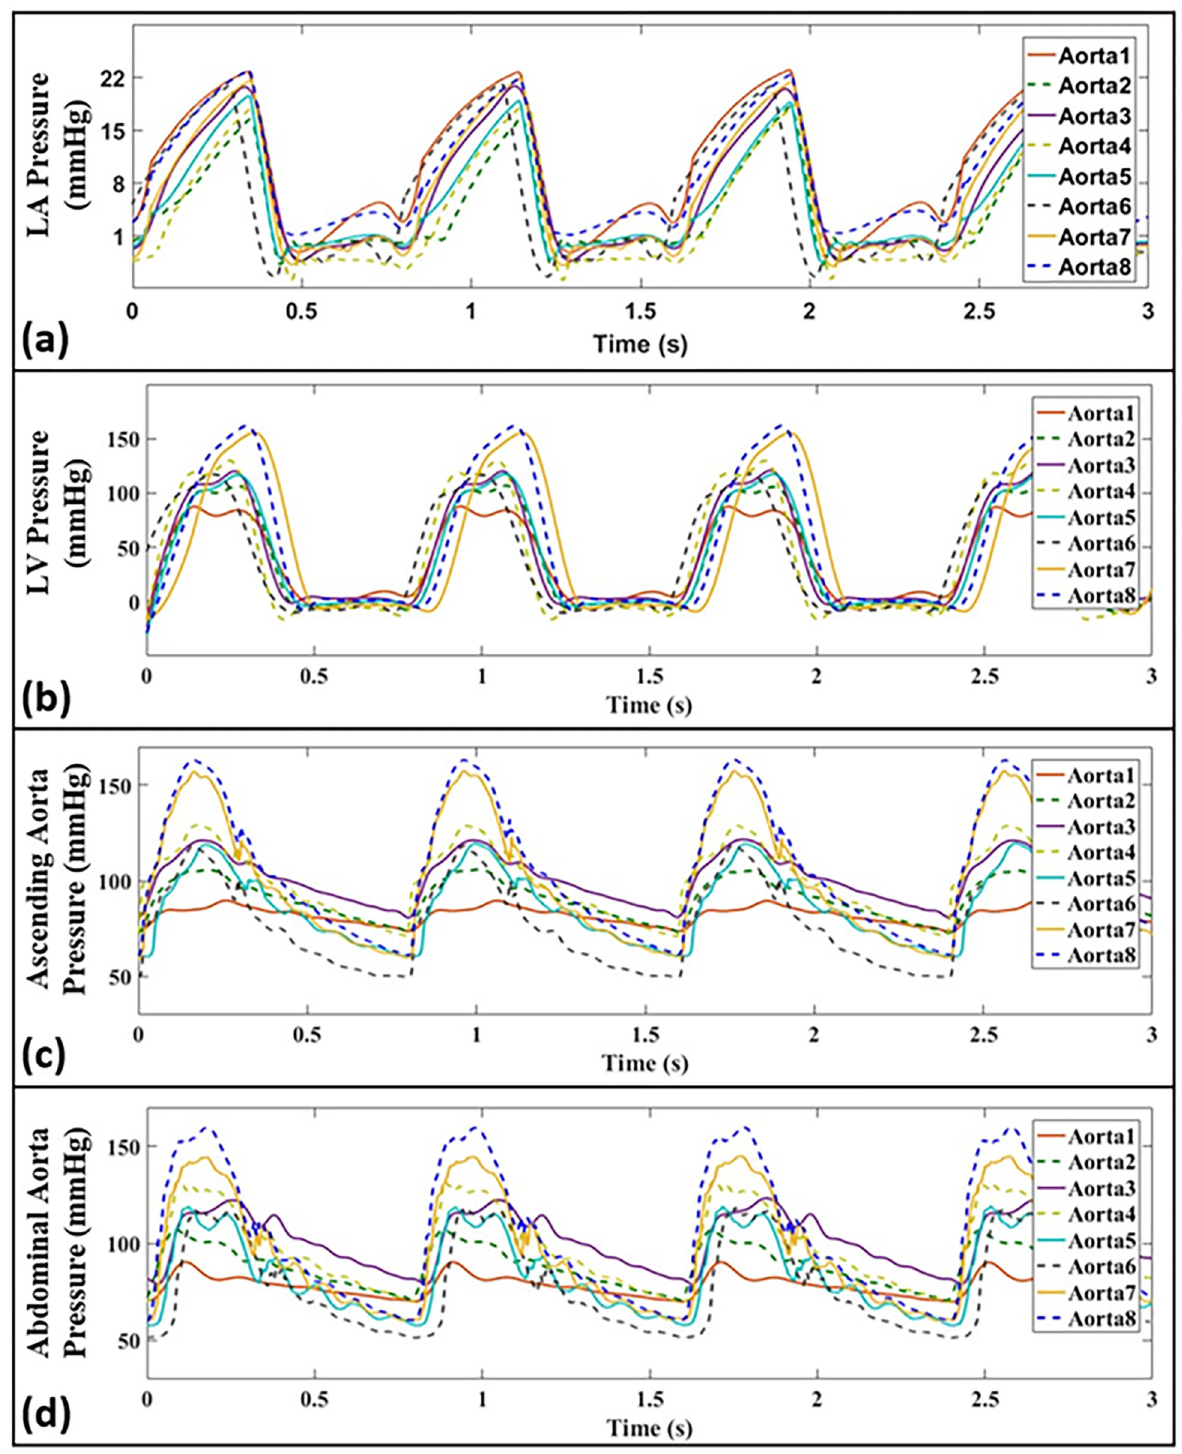
Fig 12. Pressure waveforms, corresponding to different aortas (i.e., Aorta-1 to 8) representing various aortic compliances, at different anatomical sites including (a) the left atrium, (b) the left ventricle, (c) the ascending aorta, and (d) the abdominal aorta. Waveforms correspond to CO = 5 L/ min and HR = 75